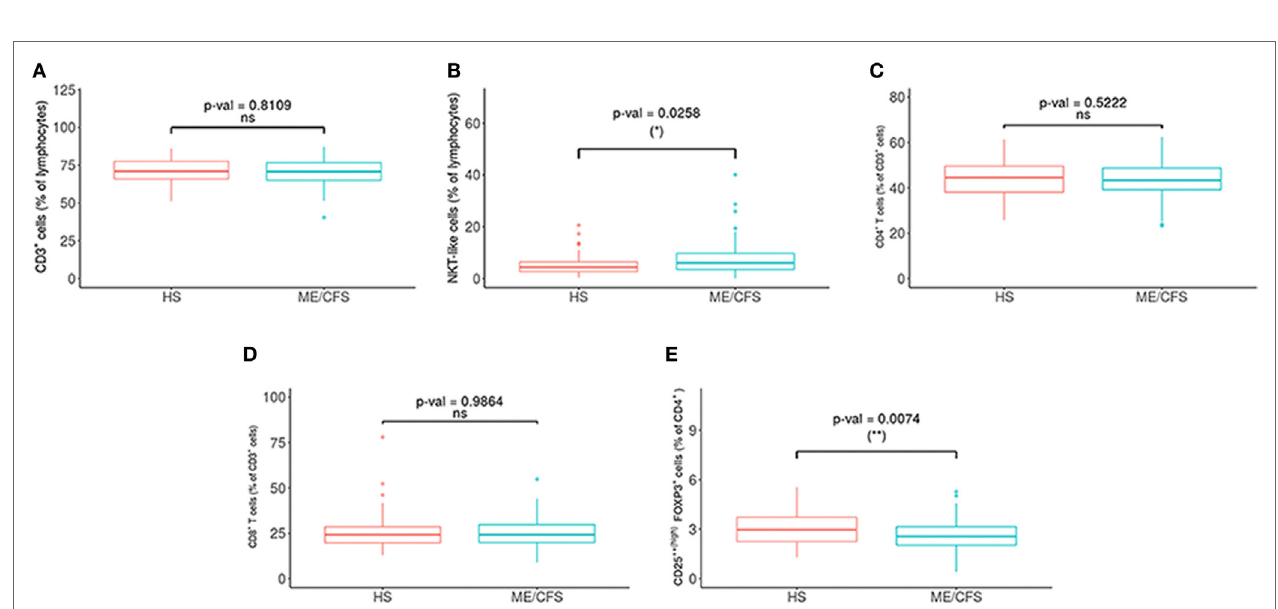
FigUre 1 | Principal component analysis (PCA) displaying all the participants of the study. (a) No differences between groups regarding the extraction date; (b) control and patients samples were analyzed using cell population data based on differential markers determined by FACS, showing the patients (blue) toward the lower right end of the plot, whereas the control group (red) is clustered toward the upper left of the plot; (c) highlighted are the variables that spread the samples in specific directions within the PCA (red